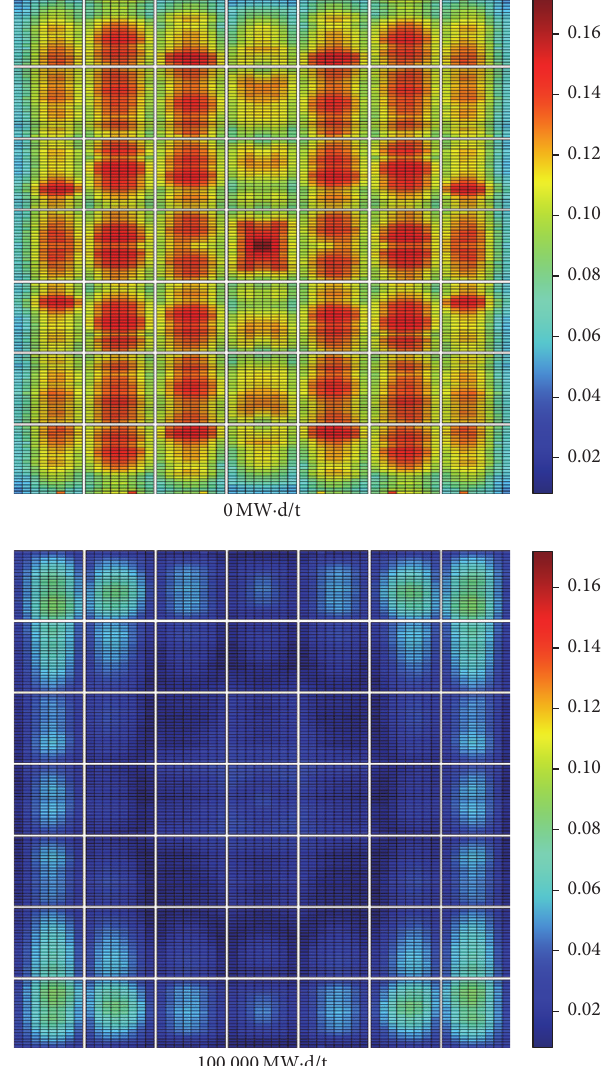
Figure 4: Uncertainty on power factors (%) induced by